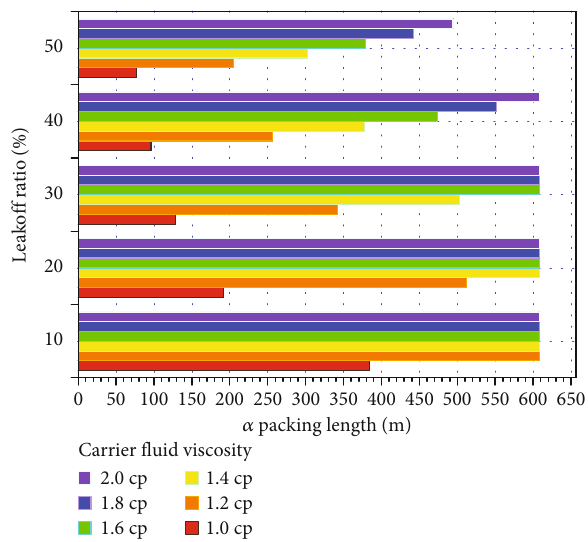
Figure 3: E ff ect of viscosity and leako ff on α wave packing